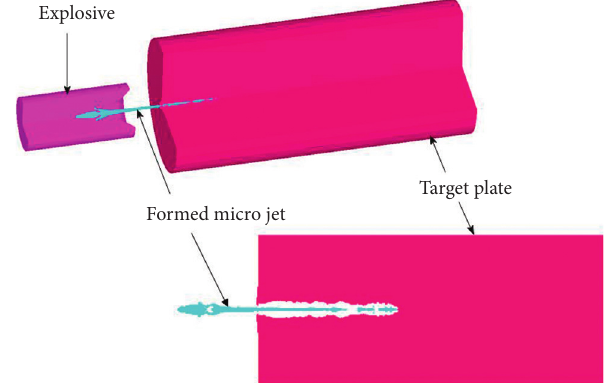
Figure 8: Penetration process of micro-shaped charge jet into gelatin